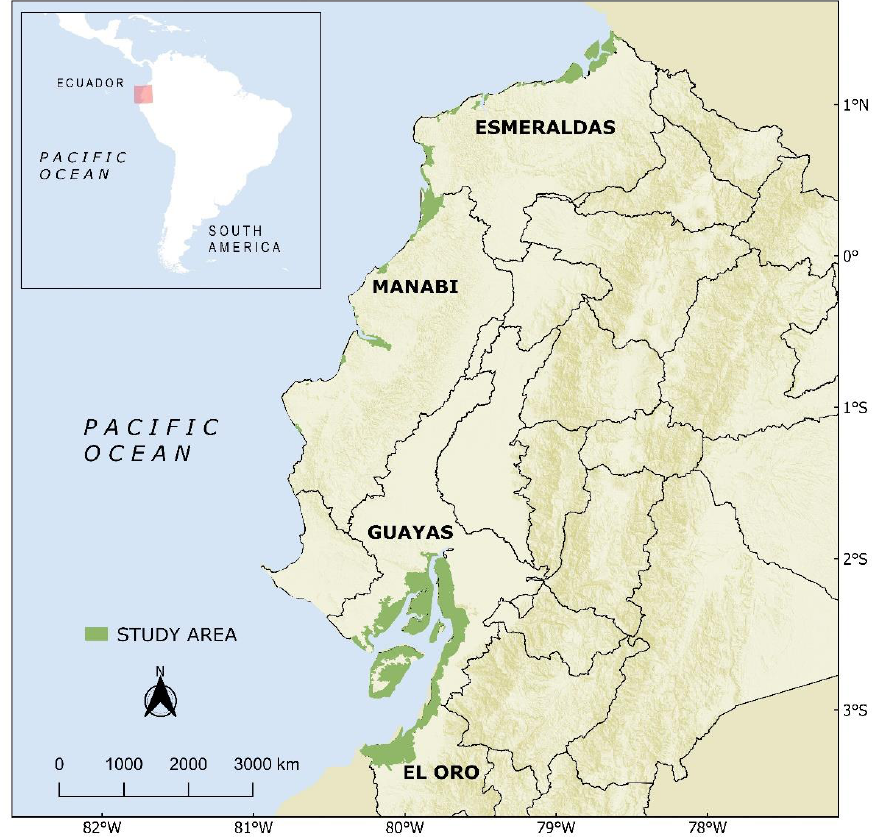
Figure 1. Potential distribution of mangrove forests along the Ecuadorian coastline.